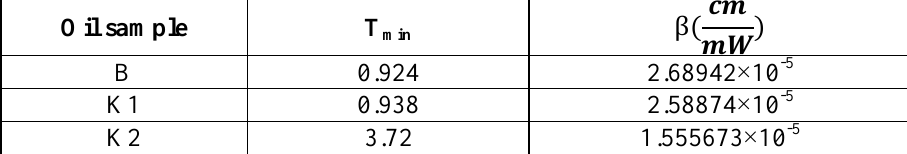
Table 4: The experimental results for the three samples in OA.